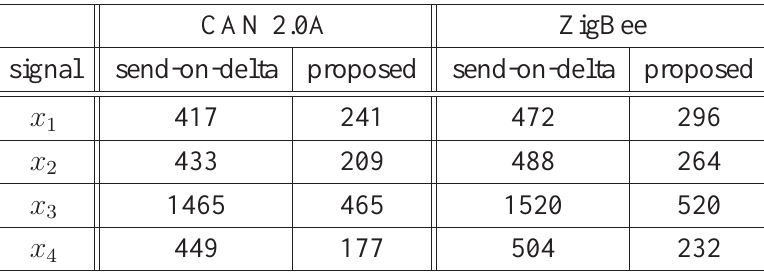
Table 6 . Total number of transmitted